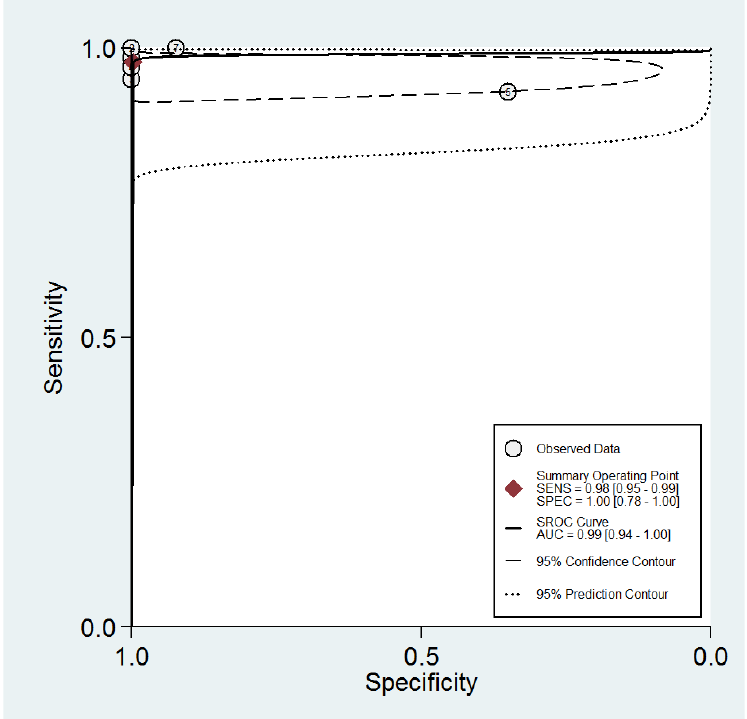
Figure 11. Summary ROC curve for the diagnostic performance of three-dimensional transvaginal ultrasonography to detect uterine septum, showing the sensitivity and specificity for each study and pooled estimation. The dashed line around the summary point estimate (red diamond) represents the 95% confidence region. The dotted line showing the 95% prediction contour corresponds to the predicted performance taking into account all individual